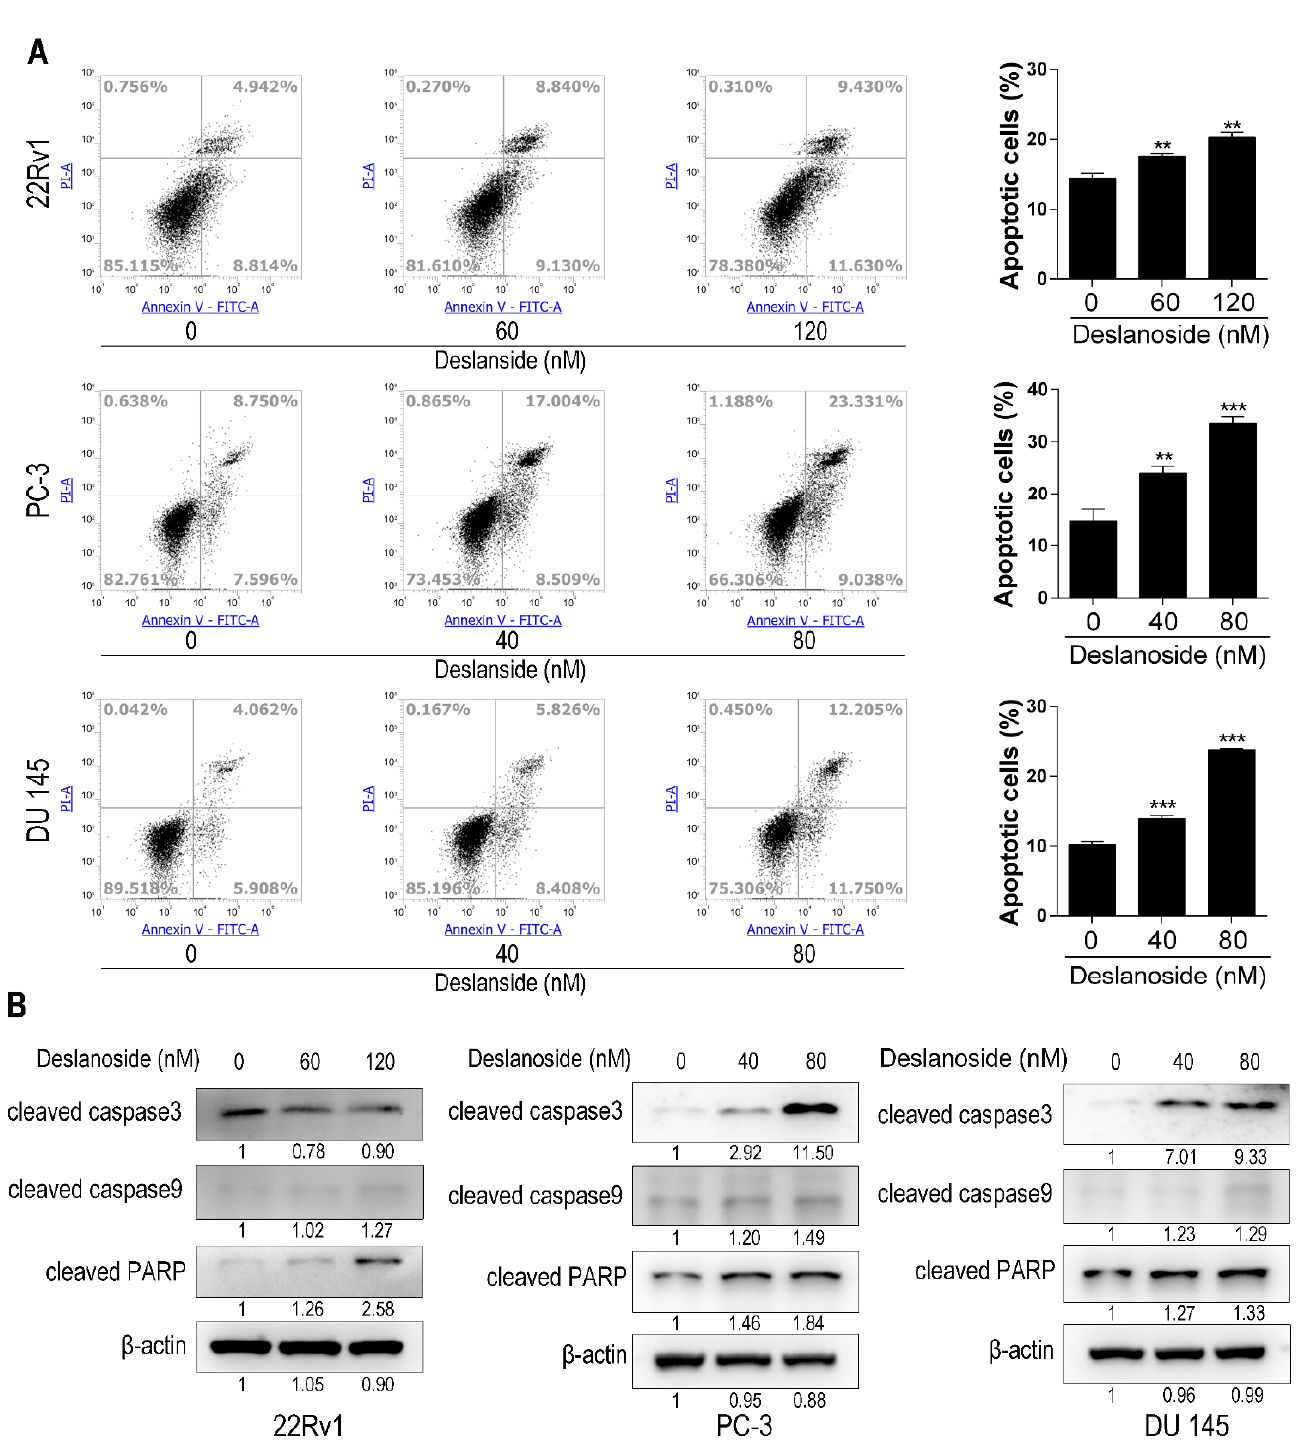
Figure 3. Deslanoside induces apoptosis via caspase-mediated cleavages in PCa cells. ( A ) Detection of apoptotic cells by flow cytometric and annexin V-FITC and PI double staining in 22Rv1, PC-3, and DU 145 PCa cell lines treated with deslanoside at indicated concentrations for 48 h. Percentages of apoptotic cells are shown at right. The Student’s t-test was used to determine the statistical significance between the control and each treatment. ** p < 0.01; *** p < 0.001. Data are presented as mean ± SD of at least three independent experiments. ( B ) Expression of apoptosis-related proteins, including cleaved forms of caspase 3, caspase 9, and PARP, was detected by western blotting. β-actin was used as a loading control.